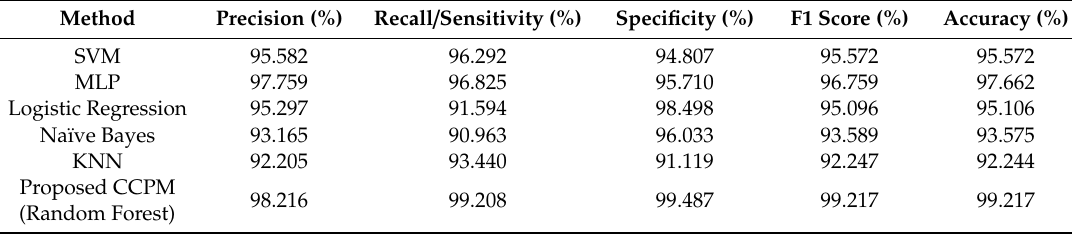
Table 10. Performance evaluation results based on DBSCAN and SMOTE for